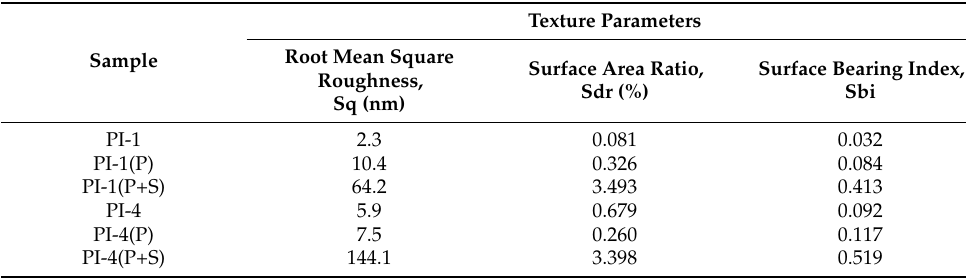
Table 2. Texture parameters calculated from the AFM height images for the pristine and surface- adapted PI-1 and PI-4 films.